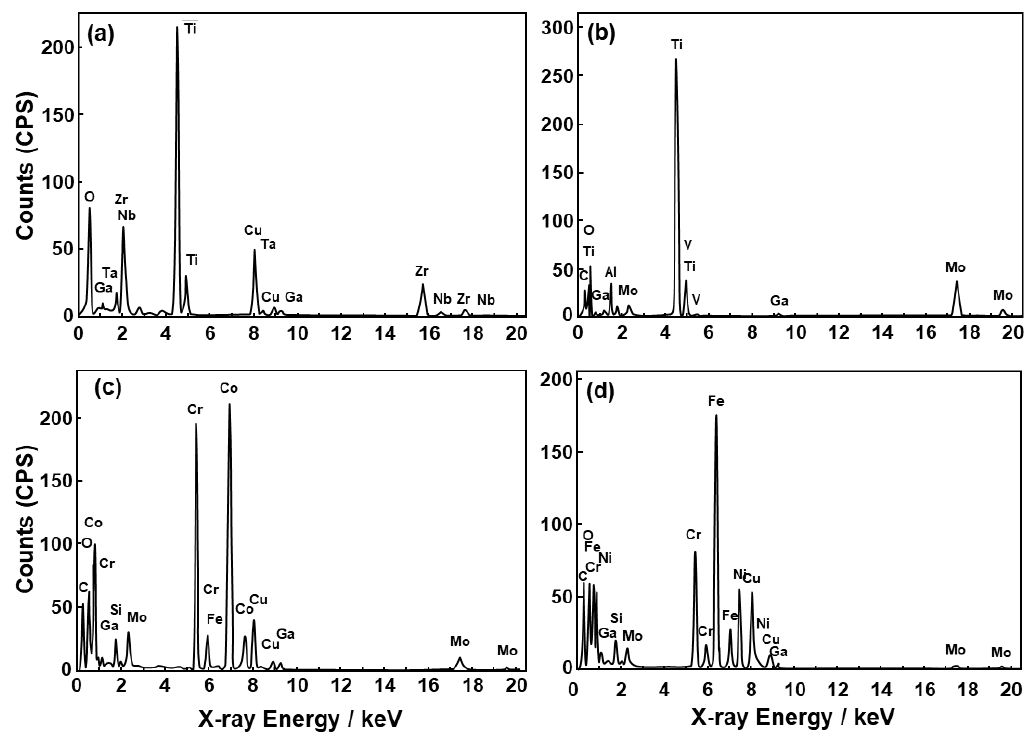
Figure 4. EDX spectra of oxide films formed on ( a ) Ti–15Zr–4Nb–1Ta, ( b ) Ti–6Al–4V, ( c ) Co–28Cr–6Mo alloy, and ( d ) high-N stainless steel at the positions shown in Figure 3.